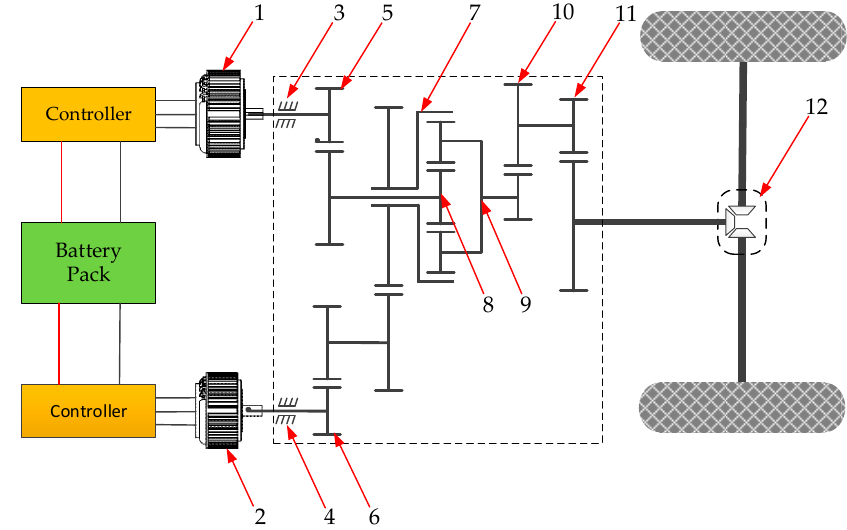
Figure 1. Schematic diagram of DICPS. 1. EM_S; 2. EM_R; 3. B1; 4. B2; 5. Reduction gear for EM_S i s ; 6. Reduction gear for EM_R i r ; 7. Ring gear; 8. Sun gear; 9. Carrier; 10. Main reduction gear i m ; 11. Final reduction gear i f ; 12. Differential mechanism.